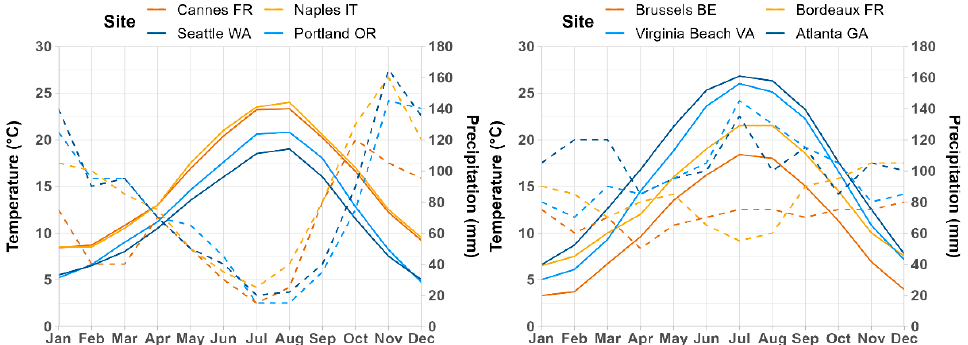
Figure 10. Climate comparisons for sites that are expected to differ in favorability for boxwood blight infections. Line plots depict monthly temperature (solid lines) and precipitation (dashed lines) across eight sites in Europe (orange lines) and the United States (blue lines). Sites with a Mediterranean climate (e.g., Cannes, France; Naples, Italy; Seattle, Washington; and Portland, Oregon) are less conducive for infections than sites that have higher humidity, few gaps in precipitation, and ideal temperatures for growth throughout the year, such as those in temperate/coastal climates in western Europe (e.g., Brussels, Belgium and Bordeaux, France) and warm and humid climates in the mid-Atlantic and southeastern regions of the United States (e.g., Virginia Beach, Virginia and Atlanta, Georgia). Data source: 1981–2010 climate normals, World Meteorological Organization (https://climatedata-catalogue.wmo.int; accessed on 24 September 2021).